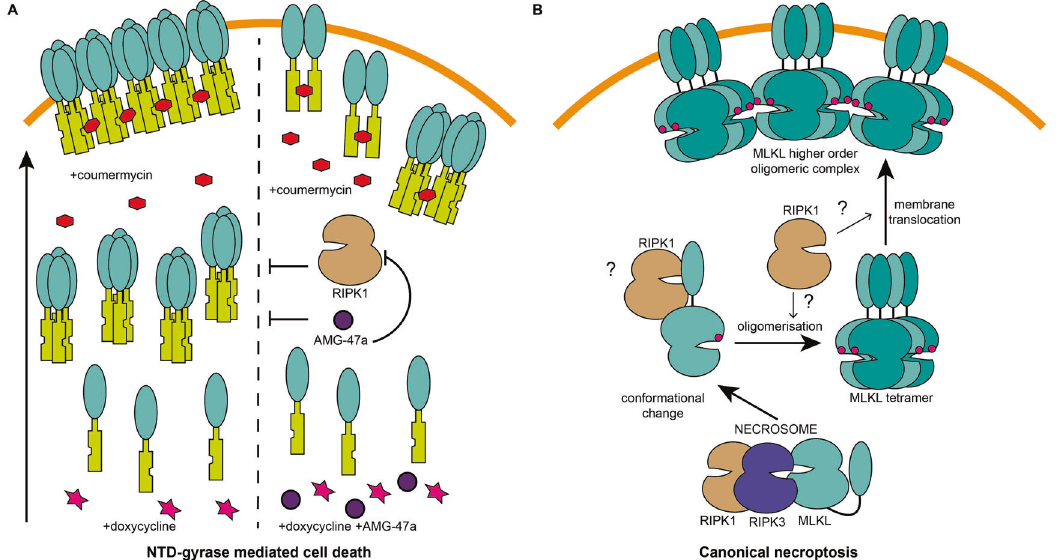
Fig. 7 Model for a role of RIPK1 in necroptosis downstream of MLKL activation. A The cell death induced by forced dimerisation of the human MLKL NTD involves two distinct processes. In the fi rst, MLKL can self-associate into discrete oligomers on addition of doxycycline. In the second, addition of coumermycin promotes the assembly of large multimeric complexes. AMG-47a is unable to inhibit the second process, thus we propose it prevents membrane attachment, translocation, or oligomerisation of the human MLKL NTD through its activity as a kinase inhibitor. As AMG-47a binds RIPK1, and as RIPK1 is required for this form of cell death, we propose the primary target of AMG-47a is RIPK1 in this context. B When a cell receives a necroptotic stimulus, a number of key events occur, beginning with assembly of a necrosome containing RIPK1, RIPK3, and MLKL. This triggers a number of events, beginning with the phosphorylation of MLKL by RIPK3, which enables a conformational change in MLKL that allows oligomerisation, translocation to cellular membranes, and ultimately cell death. Our data suggest an additional role for RIPK1 in human necroptosis by supporting the conformational change, oligomerisation, or membrane translocation of MLKL following phosphorylation by